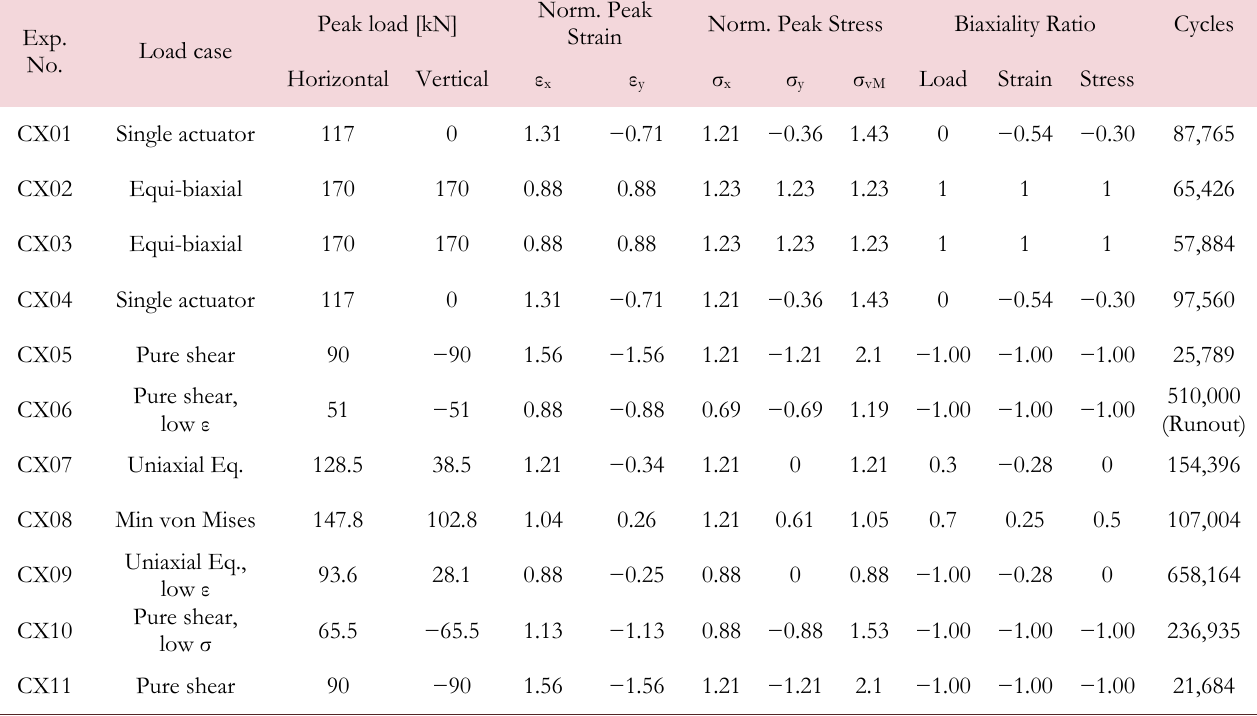
Table 1: Experimental tests parameters and